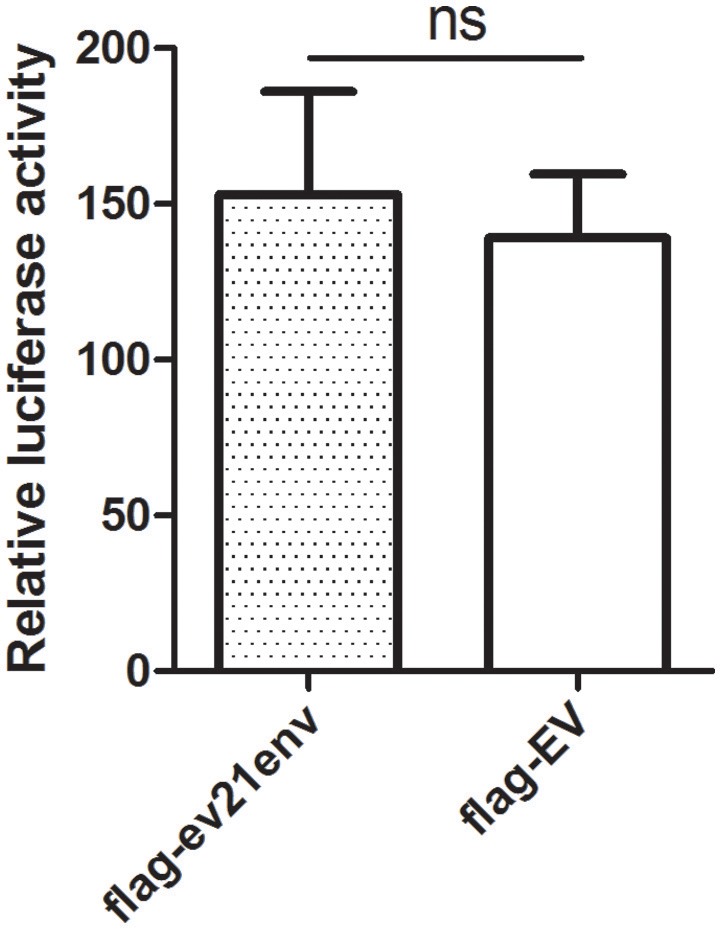
Influence of the ev21 envelope protein on M180 strain LTR promoter activity. Luciferase-reporter assay was developed to measure ALV-J strain M180 LTR promoter activity. DF-1 cells were co-transfected with pflg-ev21env, pGL3-LTR and pRL-TK plasmid and the control was co-transfected with pflg-empty vector (EV), pGL3-LTR and pRL-TK plasmid. At 24 h post-transfection, cells were lysed for luciferase detection. ns, not significant.